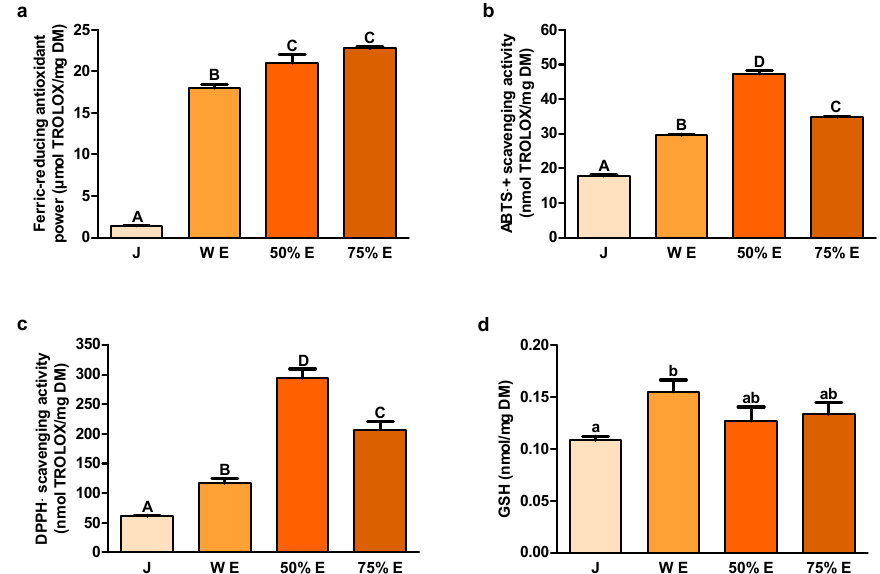
Figure 2. Indicators of redox state: ( a ) ferric-reducing antioxidant power; ( b ) ABTS · + (2.2 ′ -azino-bis(3-ethylbenzthiazoline-6-sulfonic acid) radical cation) scavenging activity; ( c ) DPPH · (2.2-diphenyl-1-picrylhydrazyl radical) scavenging activity and ( d ) GSH (glutathione) in juice (J), water extract (W E), 50% hydroethanolic extract (50% E) and 75% hydroethanolic extract (75% E) from Saposhnikovia divaricata root. Error bars indicate standard error of the mean. Statistically significant effect: values of